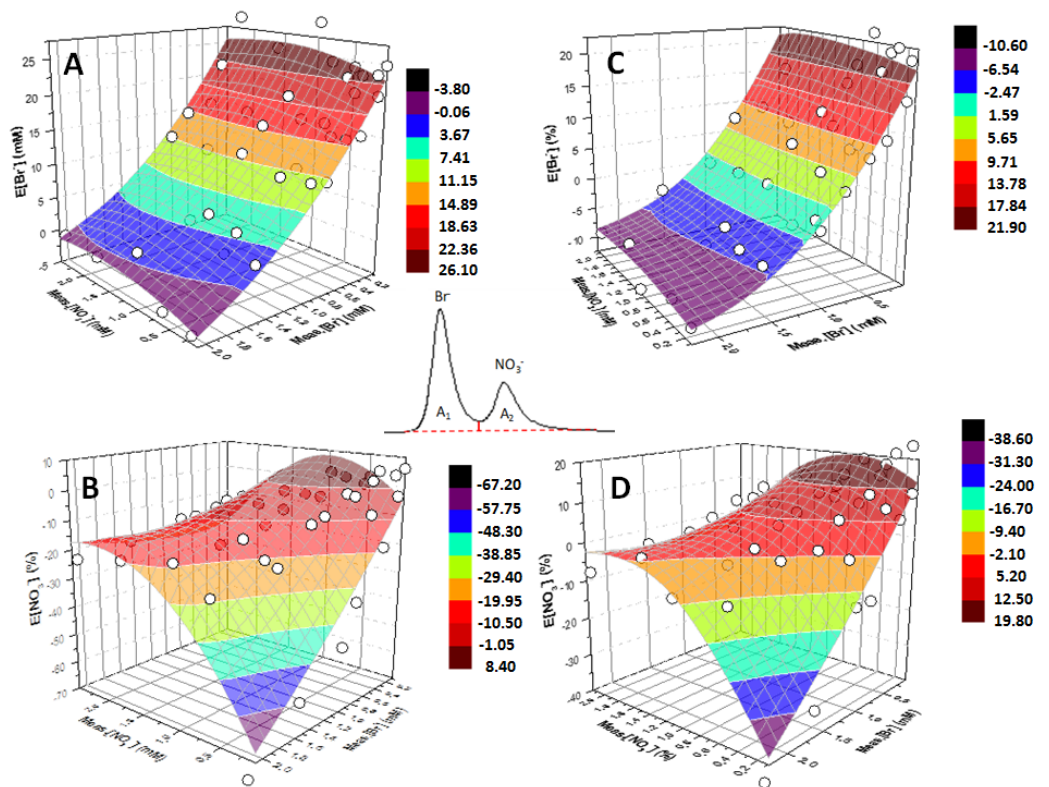
Figure 7. Inset: Chromatographic peaks obtained for a solution containing bromide (2 mM) and nitrate (1 mM) ions, integrated by splitting them with the same baseline. The integration method depicted in the inset has been used to retrieve the 3D surfaces fitting the experimental data (white circles) as triads (x, y, z) = (Meas.[NO 3 − ], Meas.[Br − ], E[Br − ]) and (Meas.[NO 3 − ], Meas.[Br − ], E[NO 3 − ]), for Figure